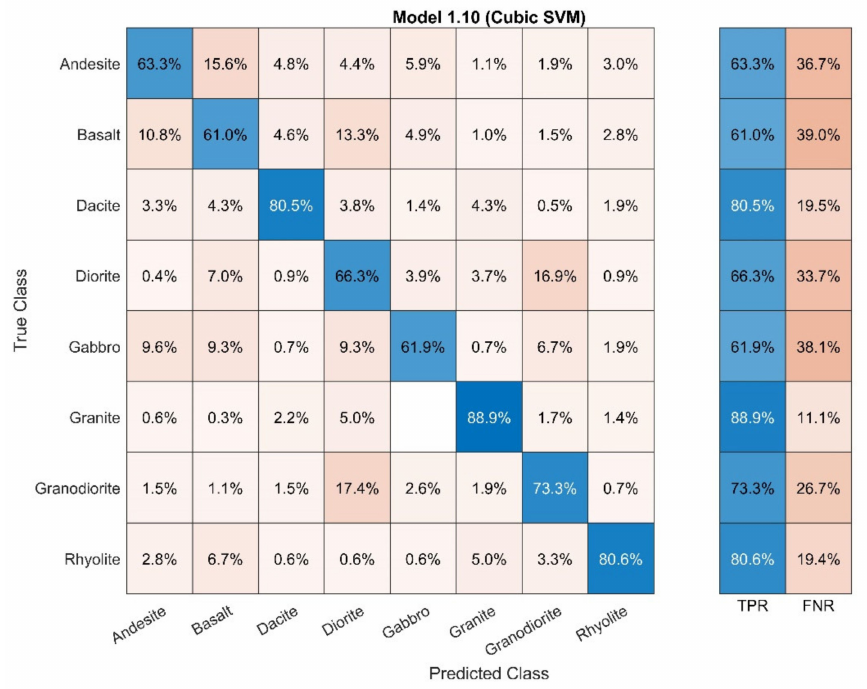
Figure 9. Confusion matrix from a Cubic SVM machine learning model used in evaluating the classification viability of post dimensionality reduction spectral